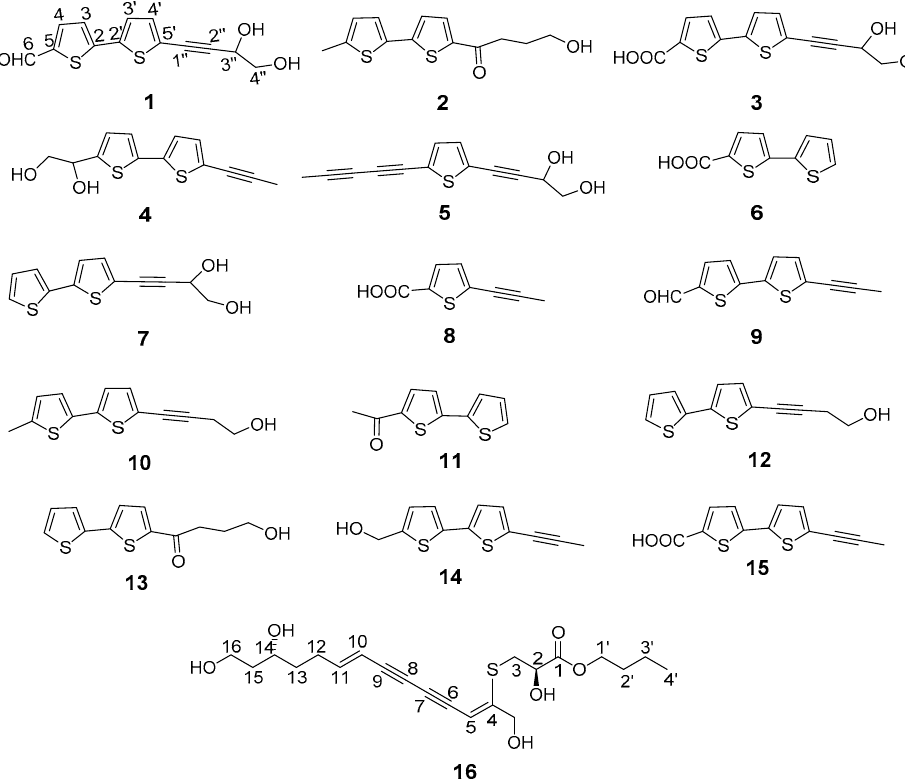
Figure 1. Chemical structures of compounds 1 – 16 from Echinops ritro L.